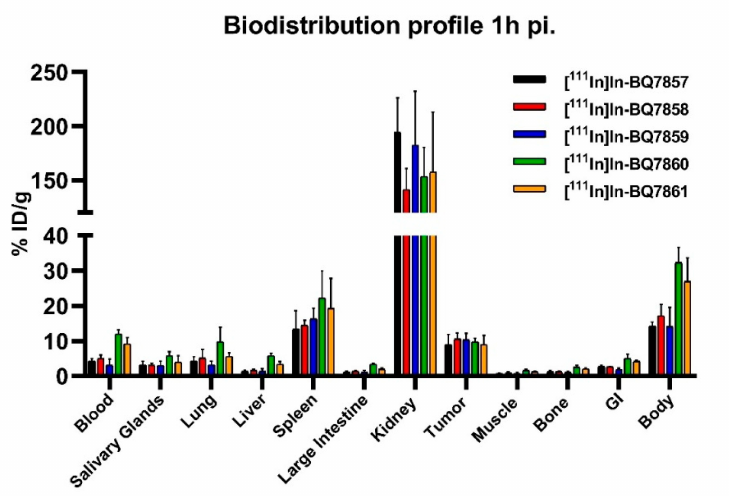
Figure 8. Biodistribution profile of [ 111 In]In-BQ7857-61 in PSMA-expressing PC3-pip tumour-bearing mice 1 h post-injection (4 mice/group). Statistical analysis was done using a one-way ANOVA with the Bonferroni’s test corrected for multiple comparisons.